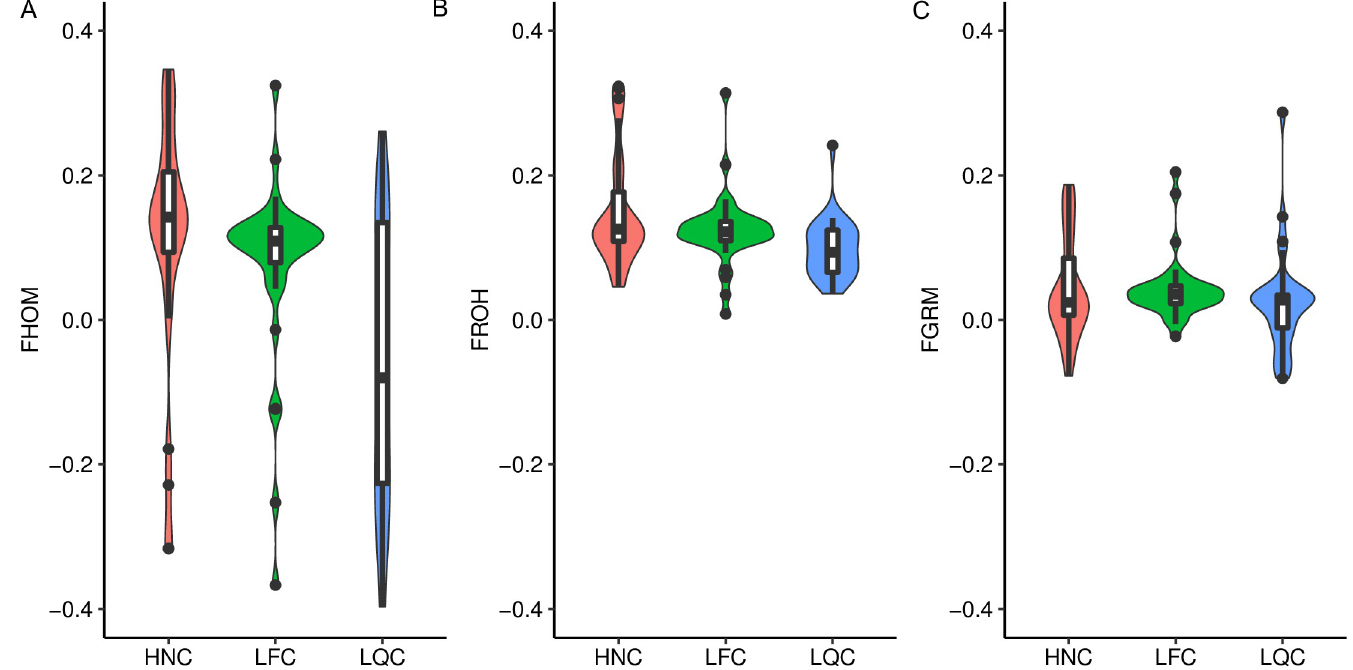
Fig 3. The distributions of inbreeding coefficient. (A) The distributions of F HOM across populations. (B) The distributions of F ROH across populations. (C)The distributions of F GRM across populations. F HOM : inbreeding coefficient based on the proportion of homozygous SNP, F ROH : inbreeding coefficient based on the proportion of the genome covered by runs of homozygosity, F GRM : inbreeding coefficient based on the genomic relationship matrix.